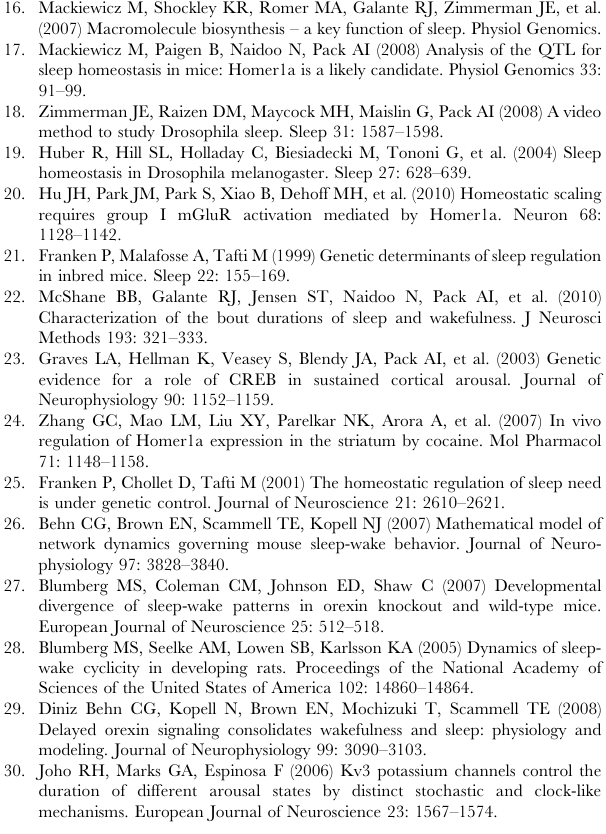
Table S4 Changes in NREM delta determined in 15 minute intervals following 6 hours of sleep deprivation. Delta is measured as % of baseline (100%). Midpoint is the chronological midpoint time of each interval measured from the end of the sleep deprivation period. There are no significant differences between